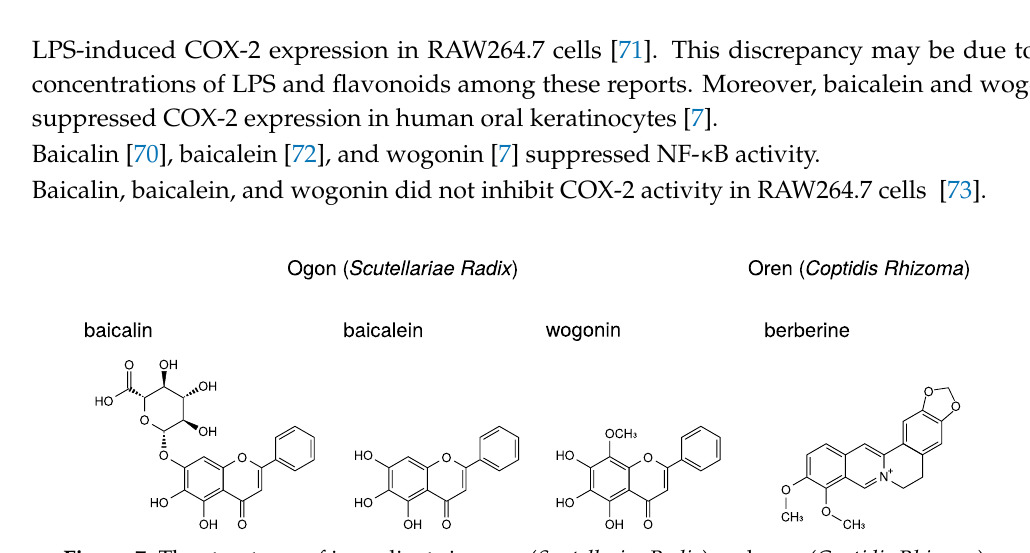
Figure 7. The structures of ingredients in ogon ( Scutellariae Radix ) and oren ( Coptidis Rhizoma